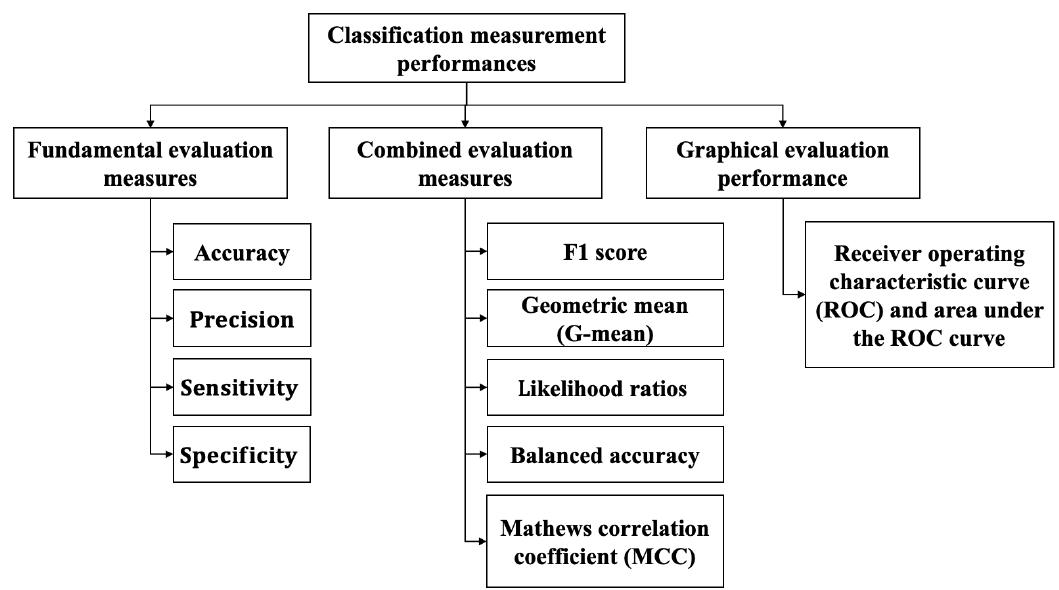
Figure 10. Classification evaluation indexes.